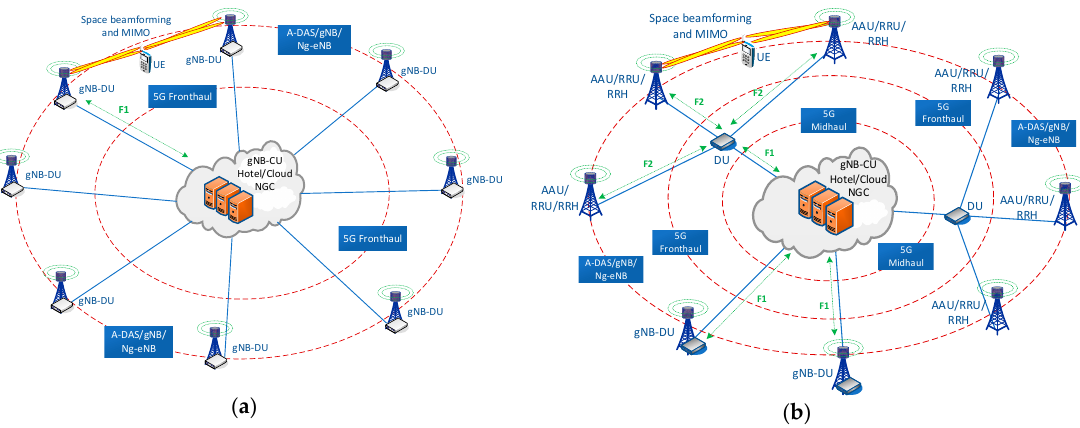
Figure 1. NG-RAN architecture with distributed gNB: ( a ) concept of C-RAN controlled by gNB-CU connected to NGC (backhaul side) and gNB-DU (fronthaul side)—forced by 3GPP; ( b ) concept of C-RAN controlled by gNB-CU/BBU connected to NGC (backhaul side) and gNB-DU/AAU/RRH (fronthaul or/and midhaul side)—forced by 5GPPP.